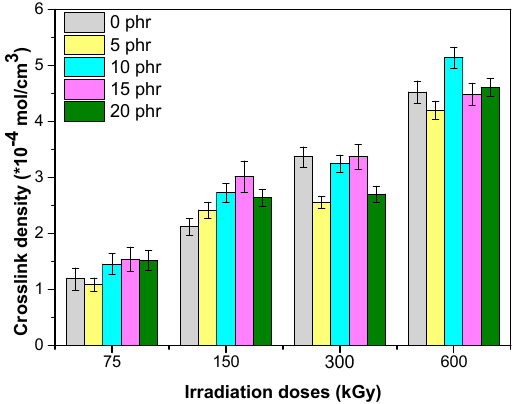
Figure 8. Crosslink density versus electron beam irradiation dose and the amount of hemp fibers.